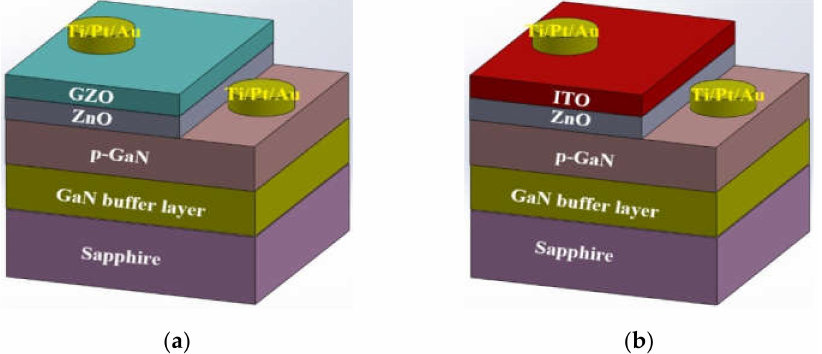
Figure 2. Schematic of device structures of n-ZnO/p-GaN LEDs with ( a ) MIPEMOCVD-grown GZO and ( b )